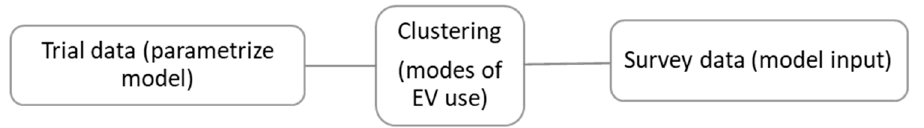
Figure 17. Overview of charging station clustering method proposed in [21].